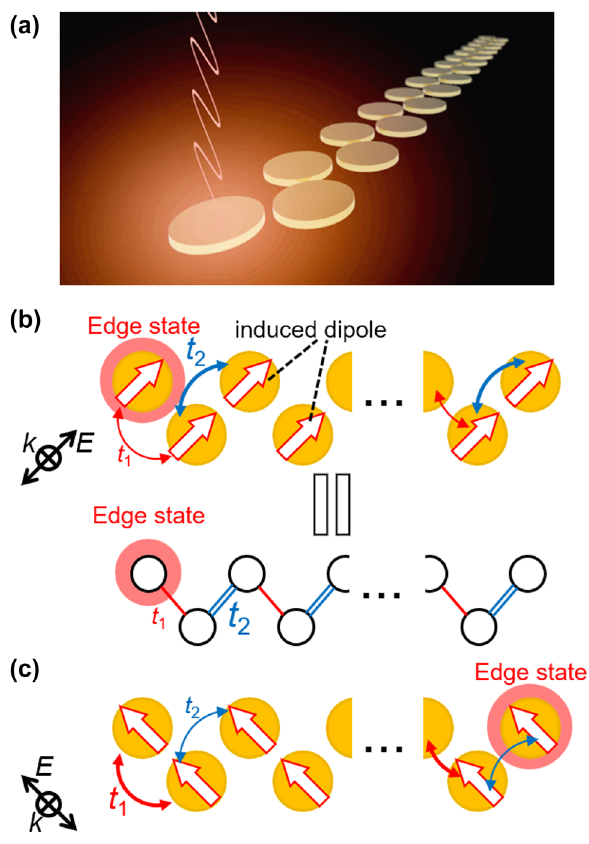
Figure 1: Principles of the topological edge states in the zigzag chain. (a) Photonic topological edge state visualized by a long zigzag chain. Gold nanodiscs are arranged in a zigzag manner. An incident light is impinged normally to the structure surface and localized electromagnetic states originating from the topological edge states are excited. (b), (c) Schematics of the zigzag chain and SSH model. The edge state positions are switched depending on the polarization